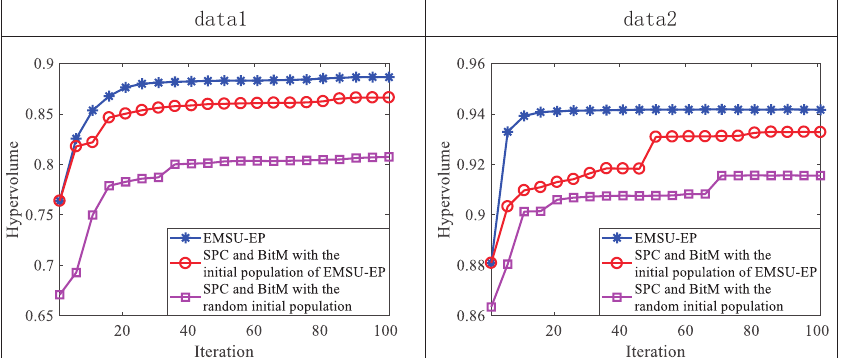
Figure 7. Illustration of the HV value of each evolution step on data 1 and data 2.